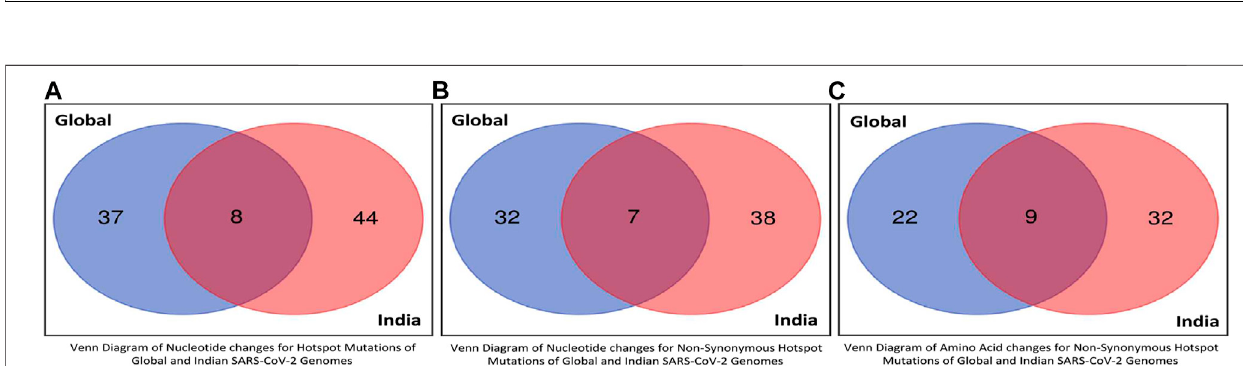
Indian sequences, 10 and 18 changes respectively decrease the stability of the protein structures. Figure 9 shows the binding af fi nity between the RBD of Spike protein and human ACE2 protein performed using SSIPe 6 (Huang et al., 2019) for the four mutations of SARS-CoV-2, viz., L452R, T478K, E484Q, and N501Y, taking place in such domain. The